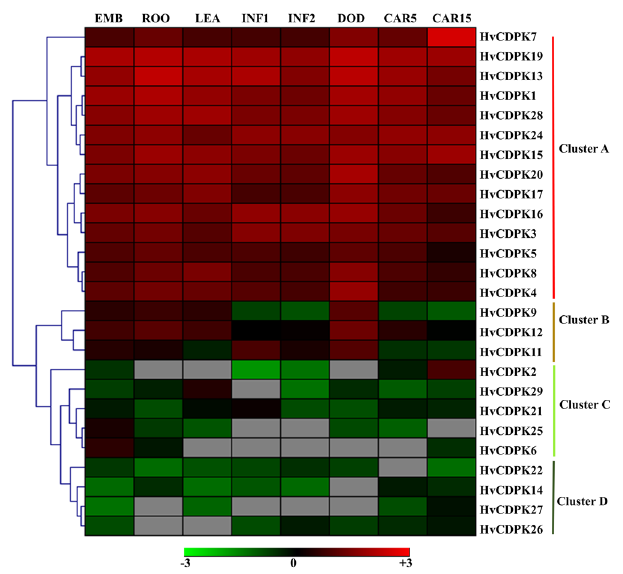
Figure 3. Expression profiles of barley CDPK genes in different tissues and developmental stages. Dynamic expression profiles using the FPKMs of the Hv CDPK genes in different tissues and development periods. FPKM values (log2 ratio) were gene-wise normalized and hierarchically clustered using Genesis software. Genes highly or weakly expressed are colored red and green, respectively, and gray represents the FPKM value of 0. EMB; four-day-old embryos dissected from germinating grains, ROO; roots from the seedlings (10-cm shoot stage), LEA; shoots from the seedlings (10-cm shoot stage), INF1; young developing inflorescences (5 mm), INF2; developing inflorescences (1–1.5 cm), NOD; developing tillers at the six-leaf stage (3rd internode), CAR5; developing grains, with bracts removed (5 days post-anthesis), CAR15; developing grains, with bracts removed (15 days